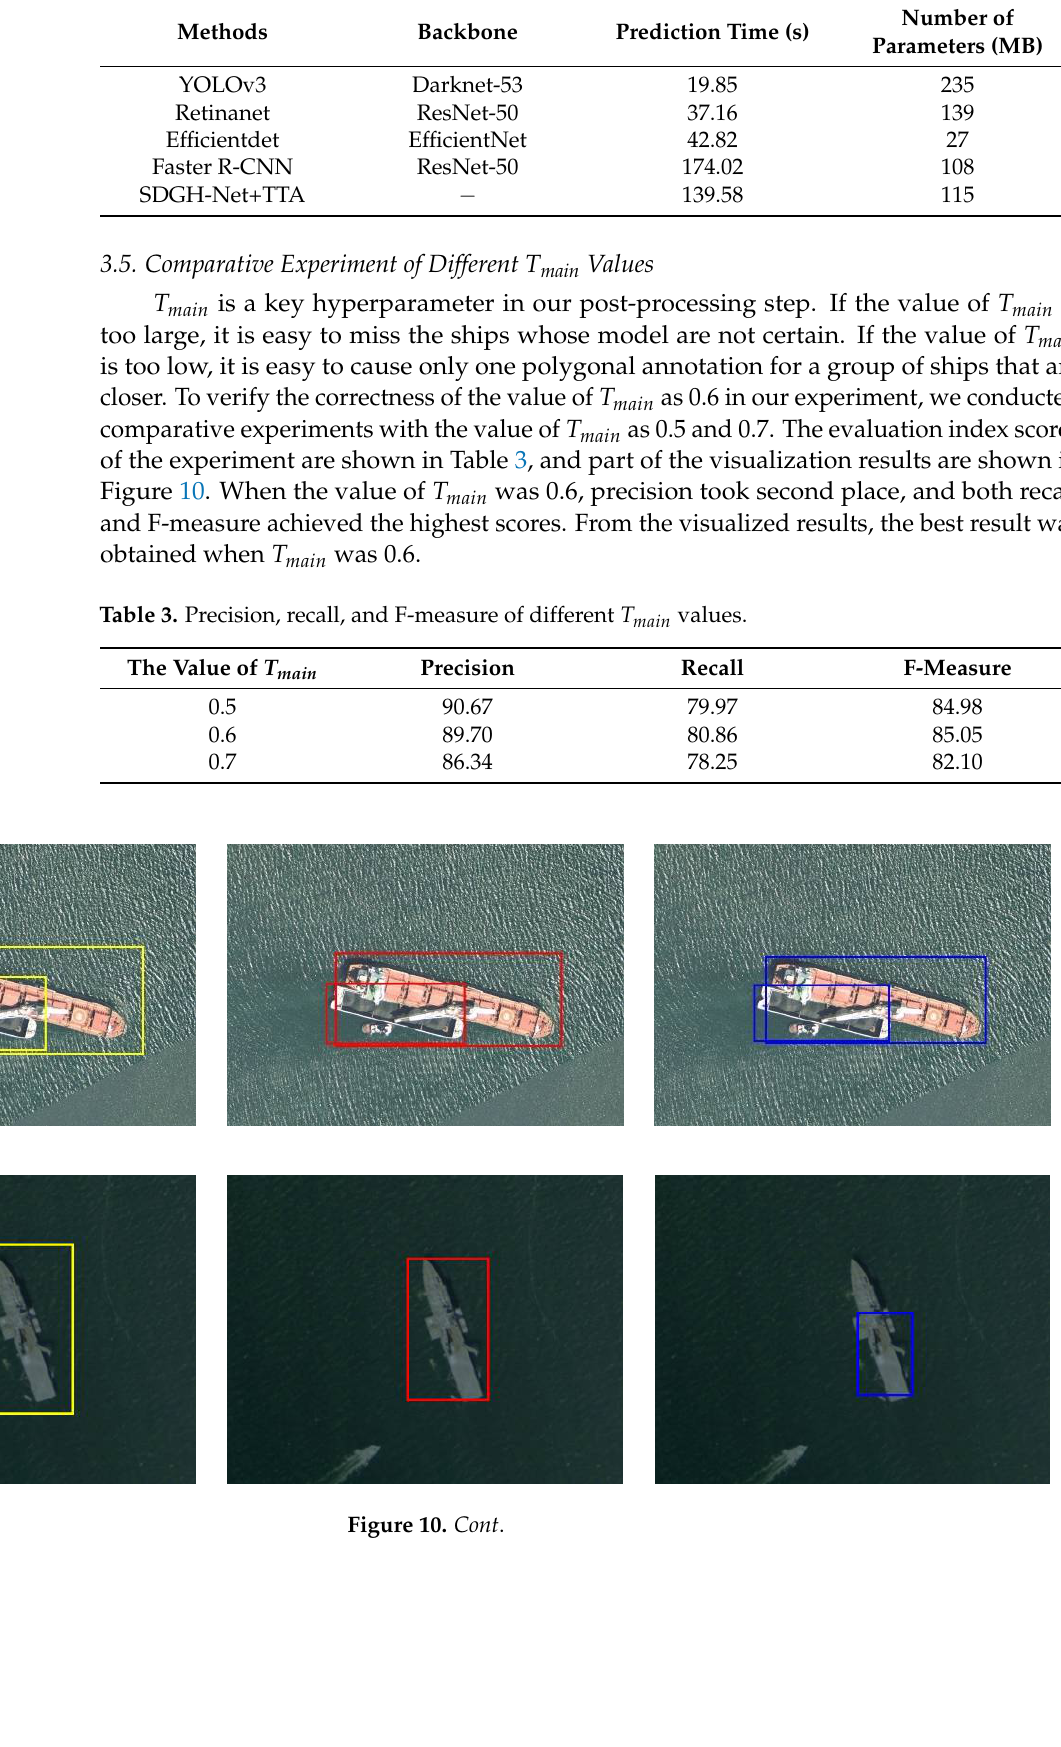
Table 2. Prediction time for test set of all methods.